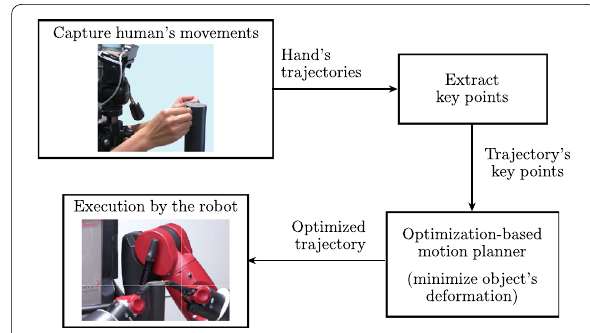
Fig. 1 Outline of the proposed framework for planning the assembly of an elastic object into a